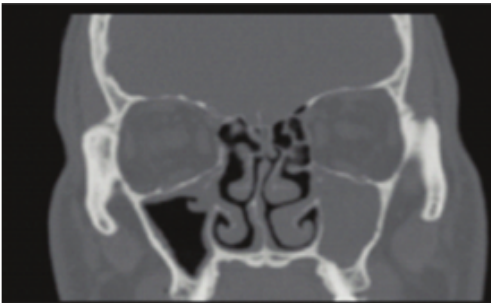
Figure 1: Computed tomography of the paranasal sinuses showing complete obstruction of left maxillary sinus and signs of chronic maxillary sinusitis on right side.